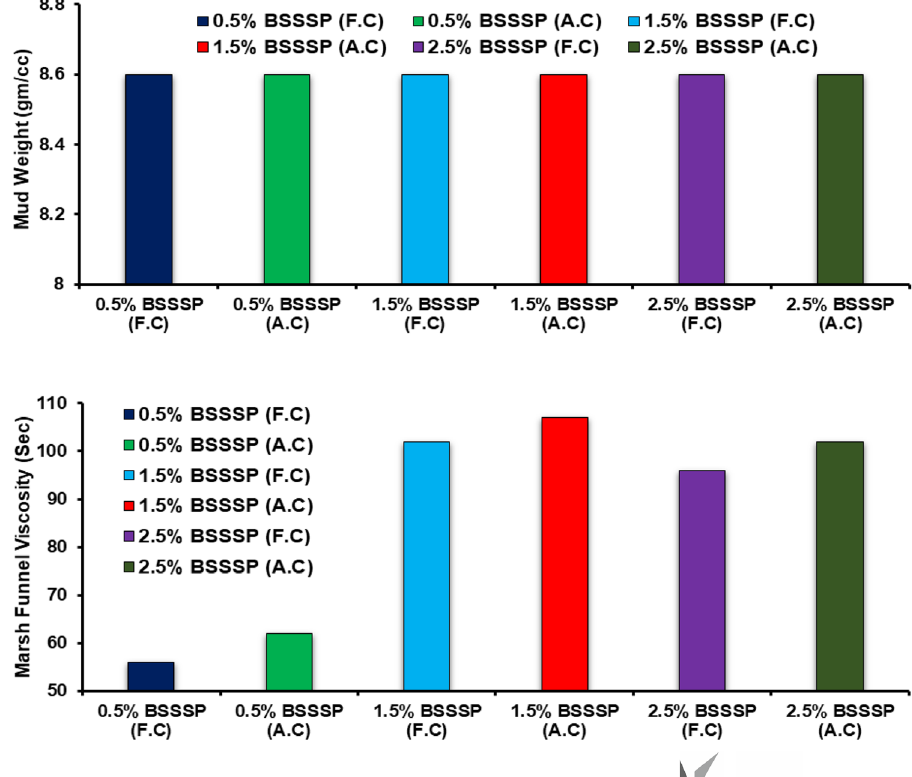
Fig. 14 Comparison between the effects of BSSSP on the mud weight under the fresh and aged conditions